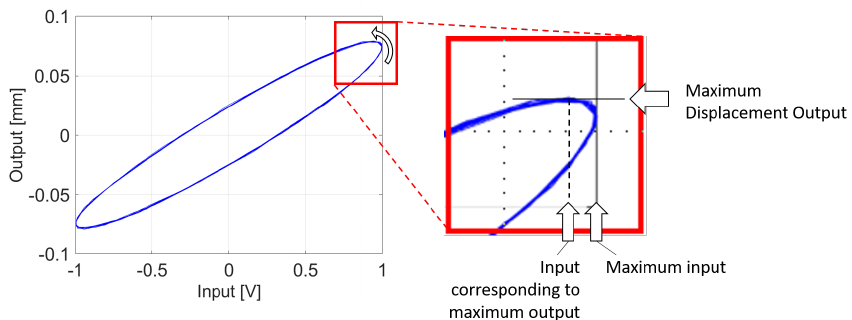
Figure 3. Input/output map of the response of the actuator to 35 Hz pure sinusoidal input. The zoomed part of the figure clearly shows that the output displacement takes its maximum value when the input already starts decreasing.